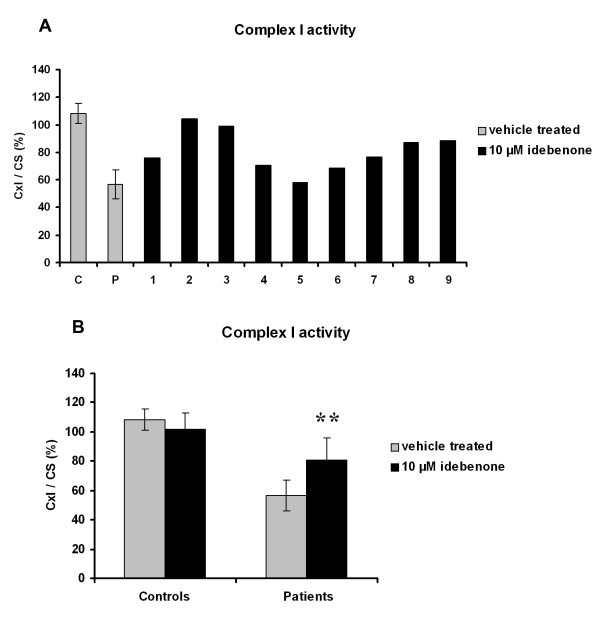
The effect of idebenone on complex I activity. A. Complex I (CxI) activity in fibroblasts from LHON patients (n = 9) and controls (n = 3) treated with vehicle (grey bars) or 10 μM idebenone (black bars) 24 h before the analysis. The enzymatic activity was standardized in terms of citrate synthase (CS) activity, indicative of mitochondrial mass and expressed as the percentage of activity of one control fibroblast used as reference in all experiments (CxI/CS(%)). B. Pooled results from fibroblasts from LHON patients and controls. Results are expressed as mean values ± SD. Statistical significance: **p < 0.01 compared with vehicle-treated fibroblasts from LHON patients. C = Controls and P = Patients.